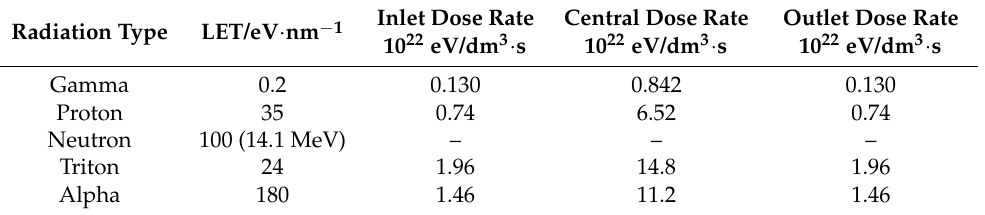
Table 10. Dose rate and LET of various forms of radiation in the radiation zone of the ITER [52,53]. Radiation Type